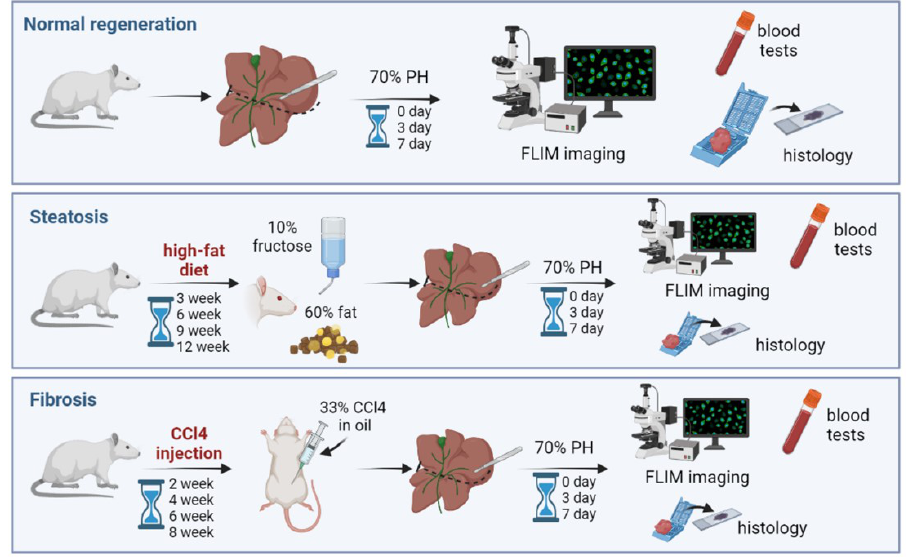
Figure 1. Road map of the steps of the experiment (normal liver regeneration: upper row; liver regeneration with induced steatosis: middle row; liver regeneration with induced fibrosis: bottom row).